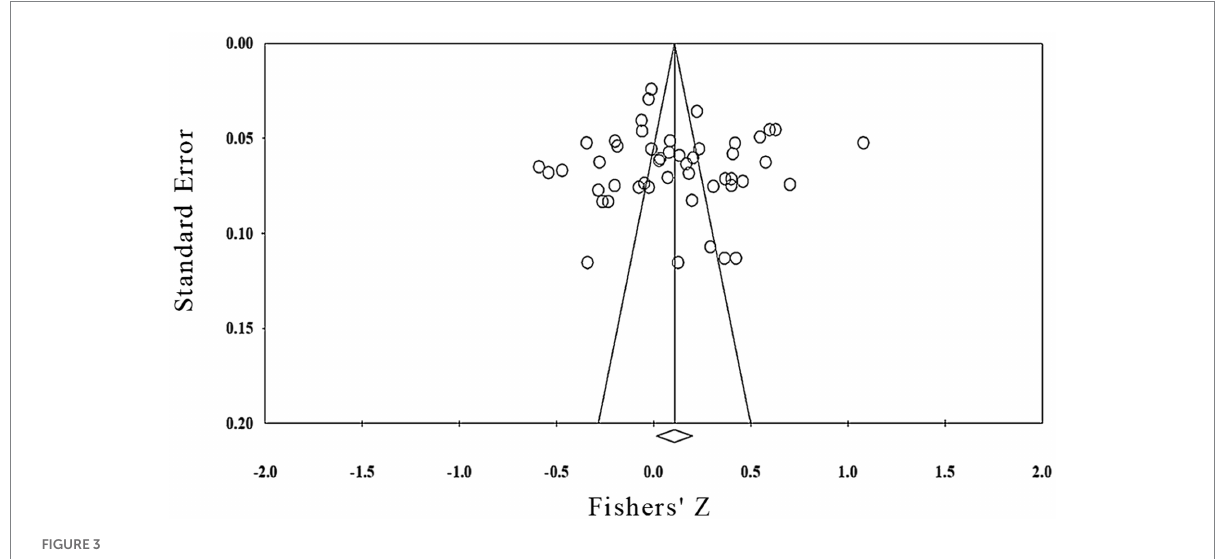
FIGURE 3 Funnel